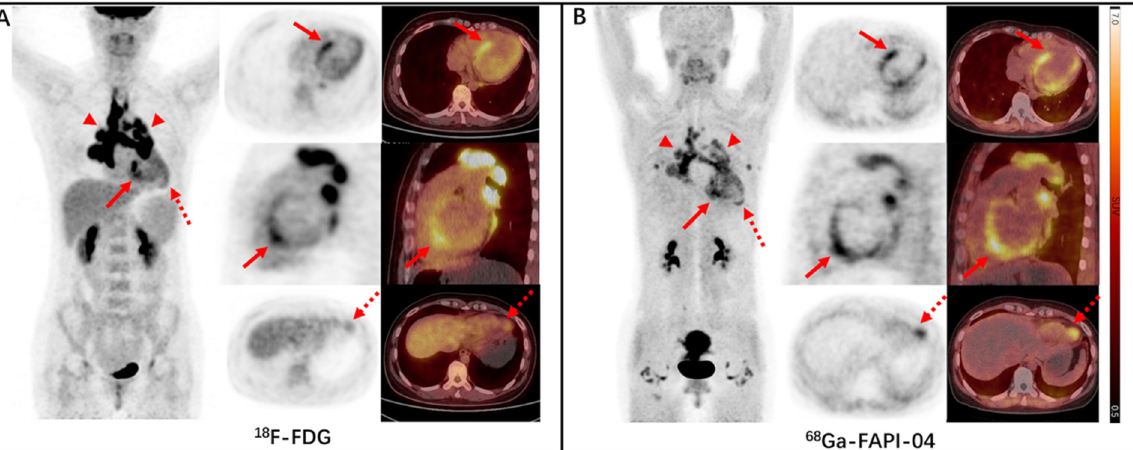
Figure 2. The oncology 18 F-FDG PET with 4 h fasting time (without the preparation of high-fat low-carb diet) presented mild heterogeneous uptake in the LV wall, particularly elevated in the septum (( A ), red solid arrows, SUVmax of 5.2). Mild uptake was observed in the apex (( A ) red dashed arrows, SUVmax of 2.7). 68 Ga-FAPI-04 PET showed significant diffuse heterogeneous uptake in the LV wall, indicating global cardiac fibroblast activation. The most prominent uptake was detected in the septum (( B ), red solid arrows, SUVmax of 6.0) and apex (( B ) red dashed arrows, SUVmax of 4.0), corresponding with the LGE regions shown by CMR. Intense uptake was also detected in mediastinal and bilateral hilar lymph nodes (( A ), red arrowheads, SUVmax of 14.8 for 18 F-FDG; ( B ), red arrowheads, SUVmax of 8.0 for 68 Ga-FAPI-04). An endomyocardial biopsy was conducted. The presence of non-caseating epithelioid cell granulomas on the histological specimens was detected, demonstrating the diagnosis of sarcoidosis. Sarcoidosis is a multisystemic in fl ammatory granulomatous disease that can manifest with nonspeci fi c clinical pictures. The diagnosis of sarcoidosis could be very challenging and a thorough evaluation [1], through the extensive overview of the disease, has been reported. The clinical course of sarcoidosis varies from a benign to life- threatening disease. An increased risk of pulmonary embolism was associated with sarcoidosis in the presence of antiphospholipid antibodies in these patients [2]. Additionally, cardiac involvement could present a life-threatening situation such as conduction disturbance, ventricular